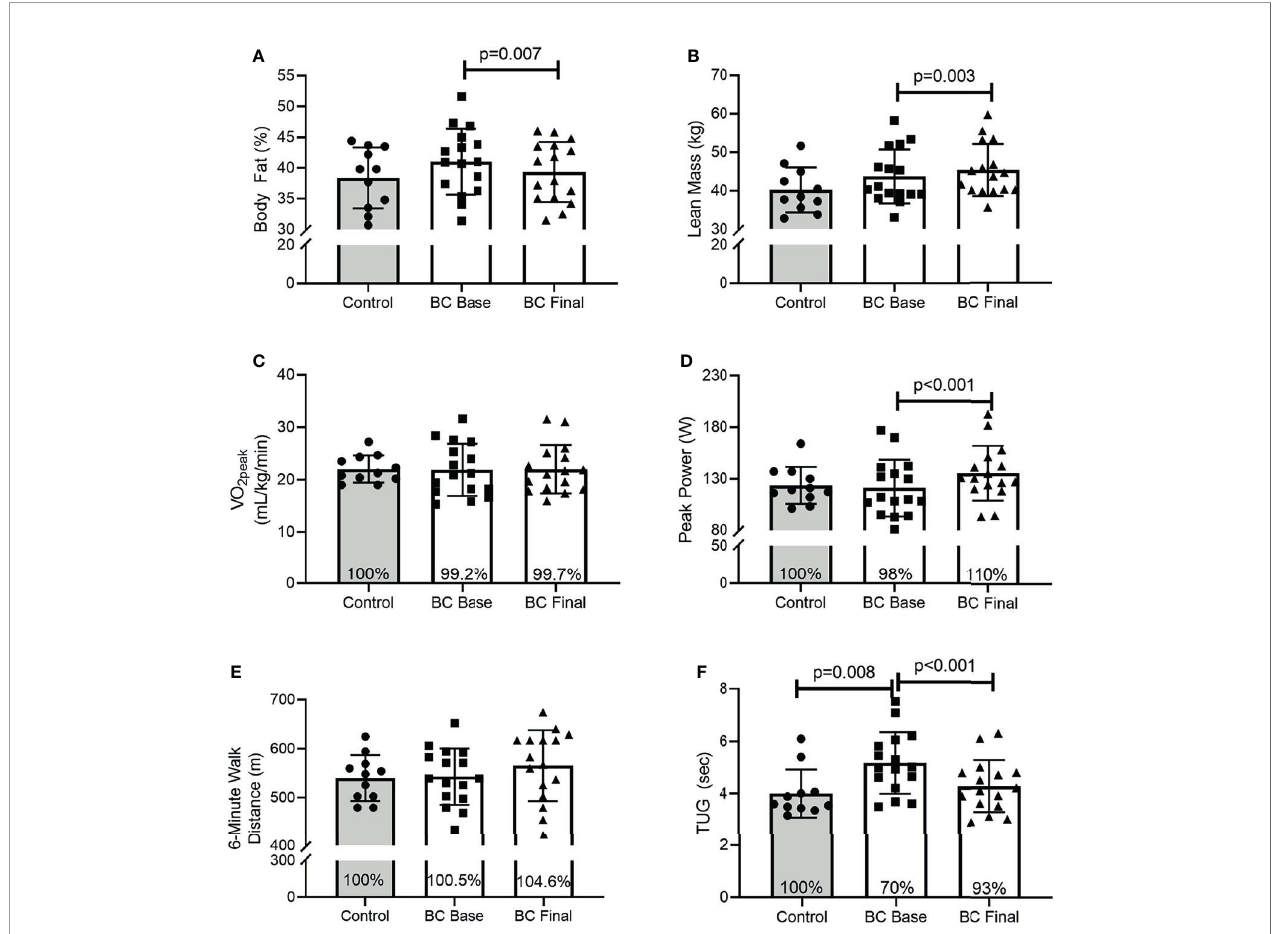
FIGURE 1 | Body composition, physical and functional fi tness between Controls and BCS measured once in Controls, and before and after 16 weeks of exercise training in BCS. (A) Body fat percentage, (B) Lean mass, (C) relative cardiorespiratory fi tness (VO2peak), (D) peak power during CPET, (E) 6-minute walk distance, and (F) Timed-up-and-go test. Where shown, the Controls mean values have been assigned 100% to represent the optimal response, and BCS the percentage of Control means. Data are mean